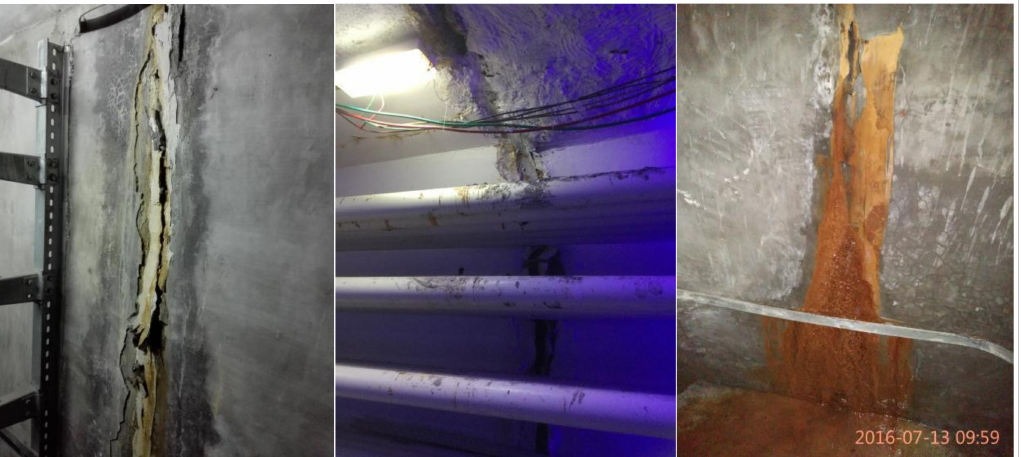
Figure 1. Leakage incidents in utility tunnels caused by failures of joint waterproof